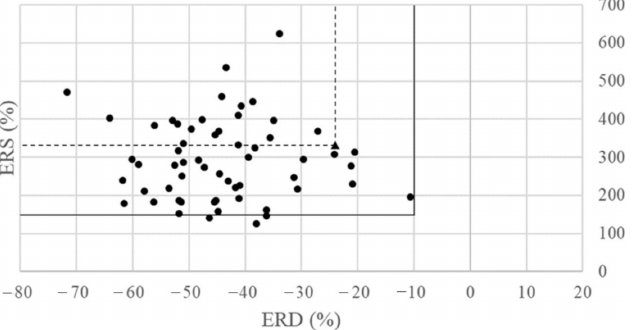
Figure 7. Plot of ERD ratio of change ( x -axis) vs. ERS ratio of change ( y -axis) derived from ICA_n20. Dotted lines indicate ERD/ERS criteria as set by session 31 (triangle). Solid lines indicate the criteria for ERD < − 10% and ERS > 150%. The number that satisfies these criteria is the number of points in the upper-left section as demarcated by the respective lines.